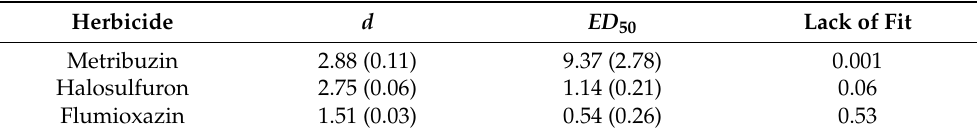
Table 2. Estimated sigmoidal parameters for metribuzin, halosulfuron and flumioxazin on A . retroflexus. Standard errors in parentheses.